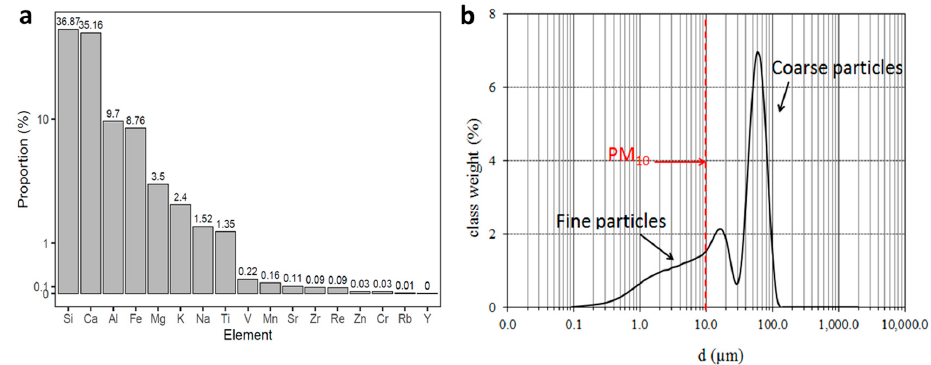
Figure 3. Chemical and physical characteristics of dust samples collected during the event of 11 February 2015. Elemental composition by X-ray fluorescence spectrometer on logarithmic Y-axis ( a ), and particle size distribution by laser diffractometer ( b ).